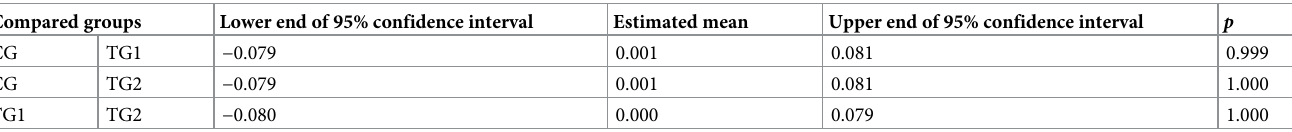
Table 4. Comparison of pre-intervention attitudes toward IT innovations ( Q pre ) for the respondents themselves (Yourself). Compared